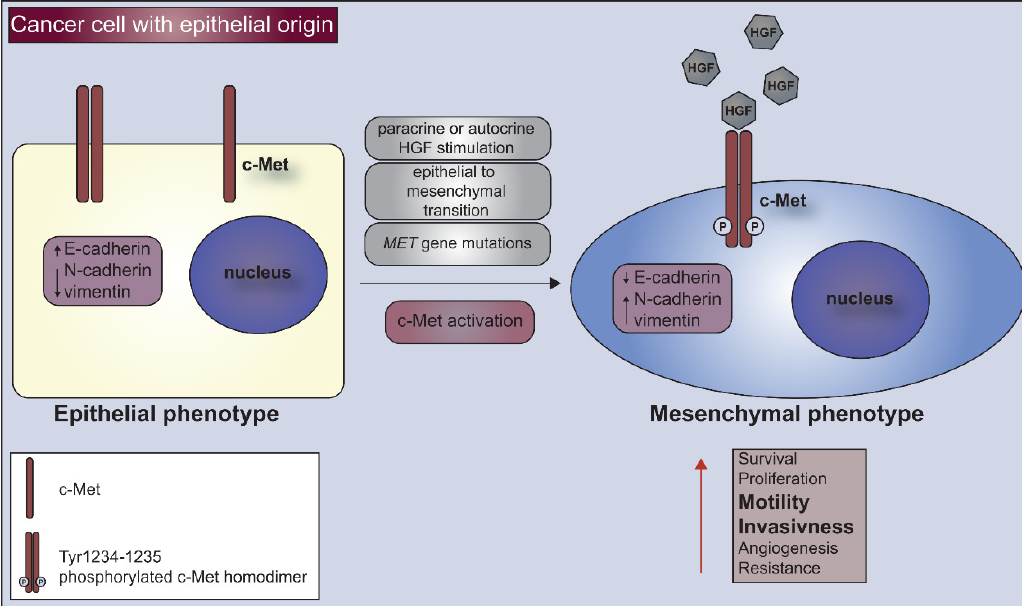
Figure 2. C-Met receptor as a marker of undifferentiated cells. Cancer cells with epithelial phenotype under hepatocyte growth factor (HGF) stimulation, epithelial to mesenchymal transition (EMT) or MET gene mutations acquire characteristics of undifferentiated, mesenchymal cells. Activation of c-Met leads to downregulation of E-cadherin and upregulation of N-cadherin and vimentin which cause increased survival, motility and invasiveness of cancer cells.